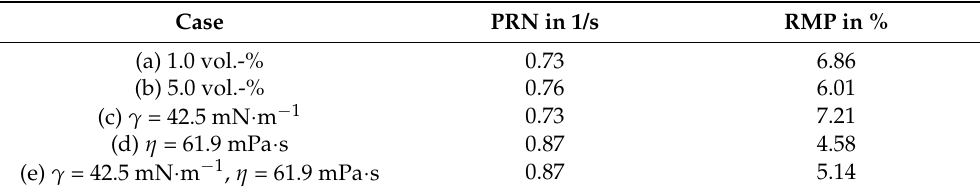
Table 4. The particle rotation number and the radial movement proportion for the five simulation